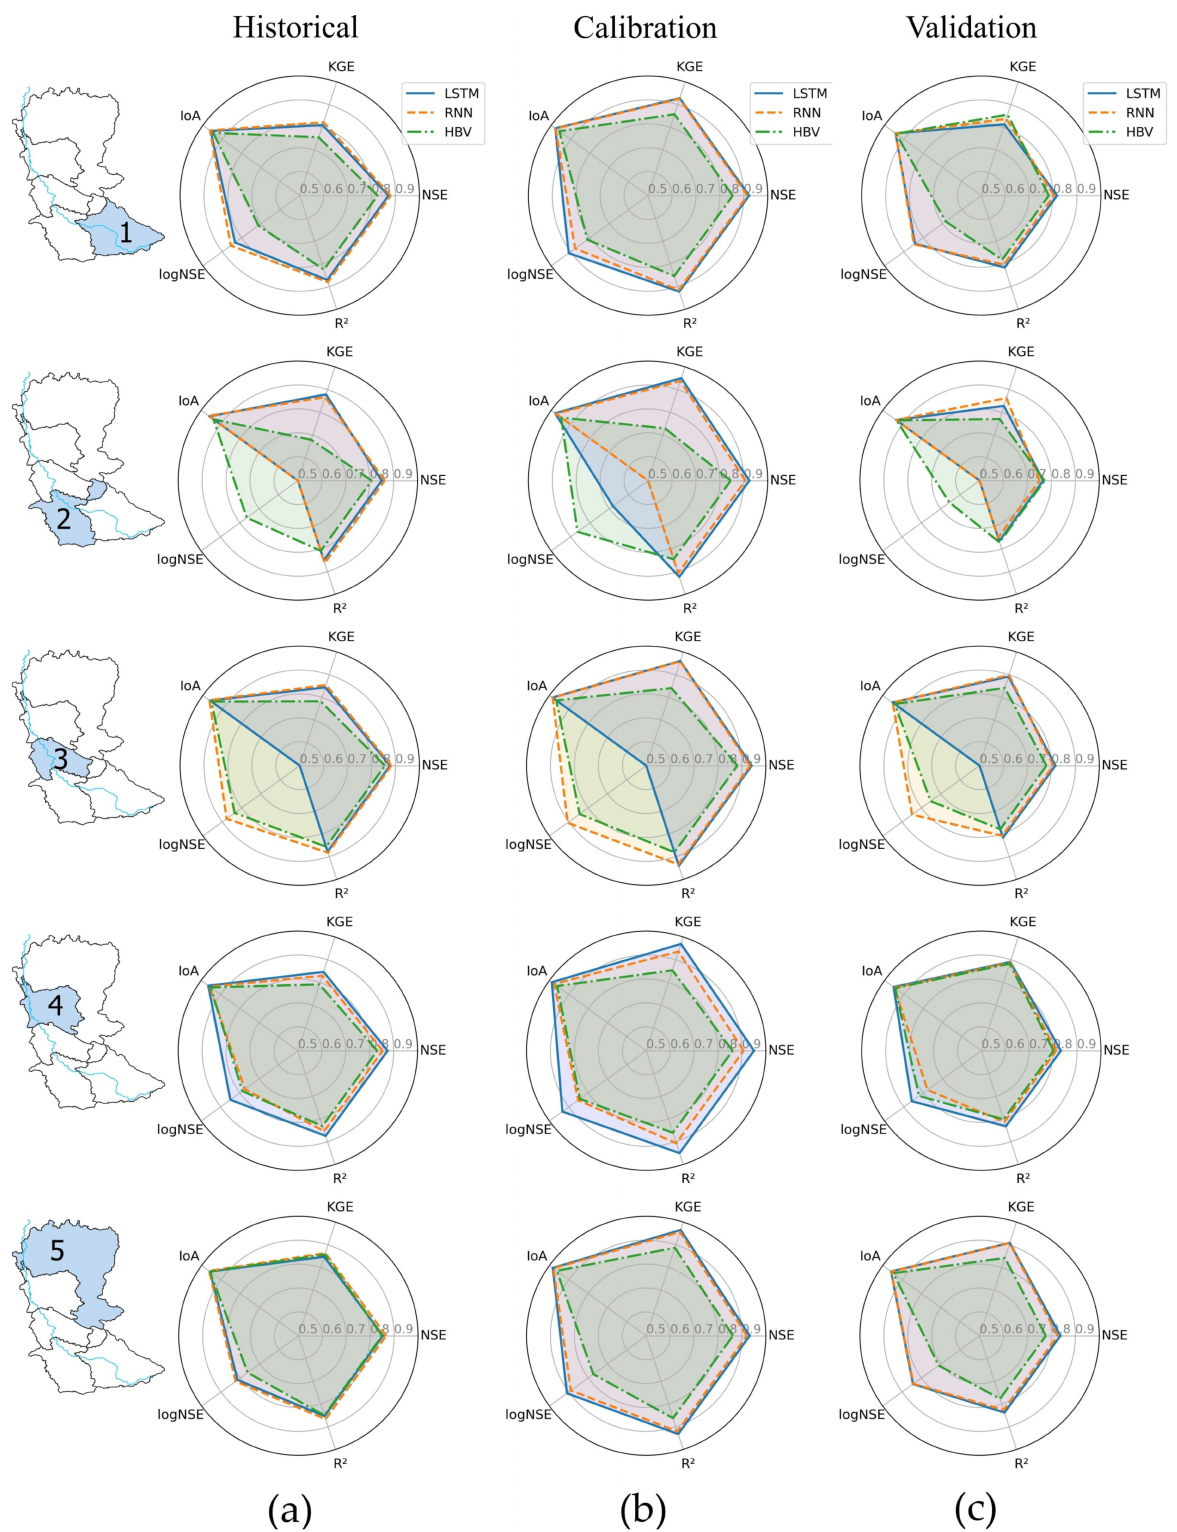
Figure 6. Radar plots showing the variety of statistical indices for the five different sub-catchments and the three different periods (historical ( a ), calibration ( b ) and validation ( c )). The minimal value visible in this figure is 0.5. Yet, in catchment 2 and 3, the logNSE value can be lower than 0.5, and, therefore, the logNSE values below 0.5 are mentioned in the following.